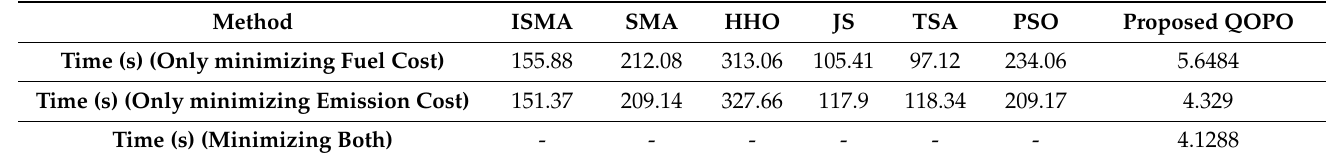
Table 16. Comparison of computational time for 11-unit system.